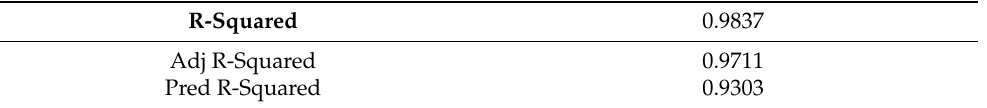
Table 7. Determination parameters used to assess and validate the model for Folin–Ciocalteau extraction.